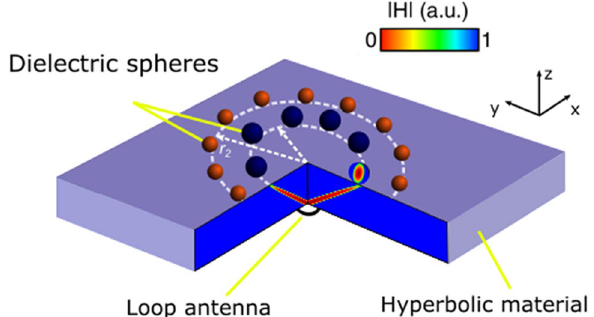
Figure 1. Structure’s layout—hyperbolic metamaterial substrate with circular array of high-index dielectric particles on top. Those arrays are responsible to provide a broadband outcoupling of energy. Each array corresponds to a specific frequency band. The structure is excited by a nonresonant loop antenna, placed underneath the